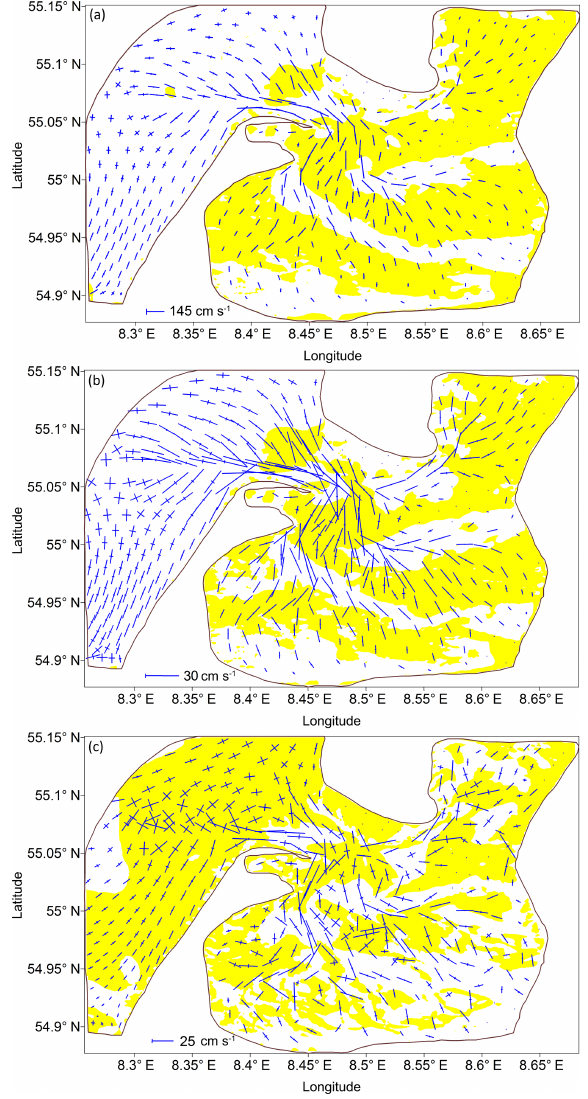
Figure 7. Axes of the (a) M 2 , (b) S 2 and (c) M 4 tidal current el- lipses and zones of the minor-to-major axis ratios. Yellow zones denote the domain of anticyclonic rotation of the current